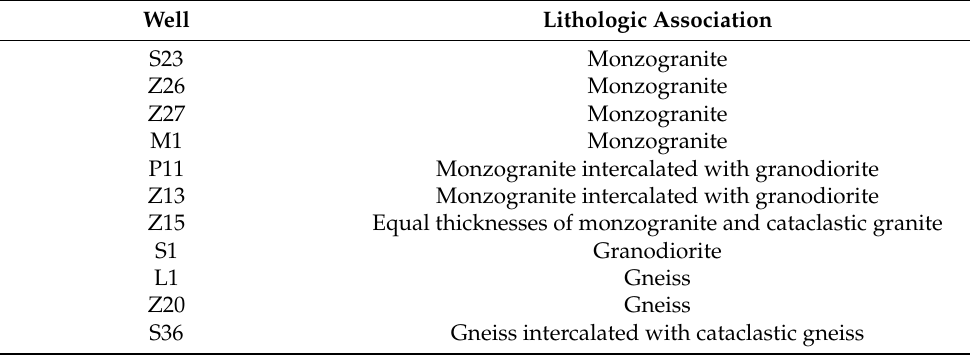
perpendicular polarized light under a microscope and the right image is of plane polarized light under a microscope. In ( d ), the left image is a cataclastic gneiss core and the right is a cataclastic gneiss thin section of perpendicular polarized light under a microscope. In ( e ), the blue triangles denote drilling samples, and the gray triangles denote outcrop samples. Well numbers are abbreviated in this article. Table 1. Lithologic association of buried hill in the LS depression in the